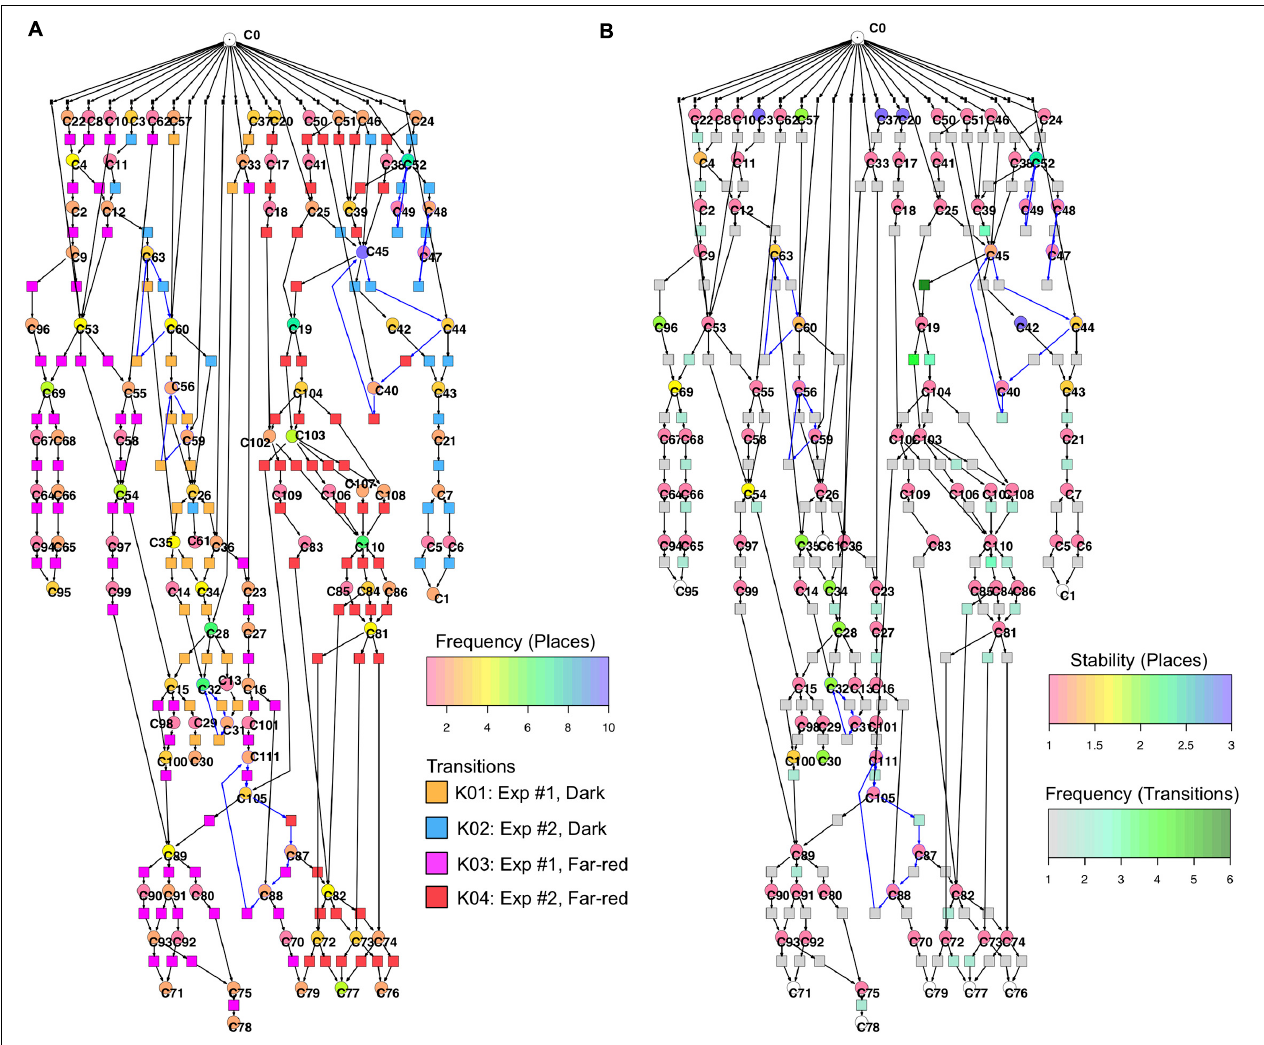
FIGURE 6 | Two copies of the same Petri net, automatically constructed from the single cell trajectories of gene expression as displayed in Table 2 . Places and transitions in the two nets were colored according to different criteria. Arcs as part of T-invariants are highlighted in blue. (A) As indicated by the rainbow color key, places are colored according to the relative frequency with which respective gene expression states occurred in the data set. Transitions are colored according to whether corresponding transits occurred in experiments #1 or #2, and whether cells were far-red stimulated or un-stimulated (dark controls), respectively, as indicated by the panel lower right. (B) Places are color coded according to the relative stability of the states of gene expression they represent. This relative stability indicates how long a cell on average resided in a certain state. The color of transitions indicates, in absolute numbers, how frequent a corresponding transit occurred in the data